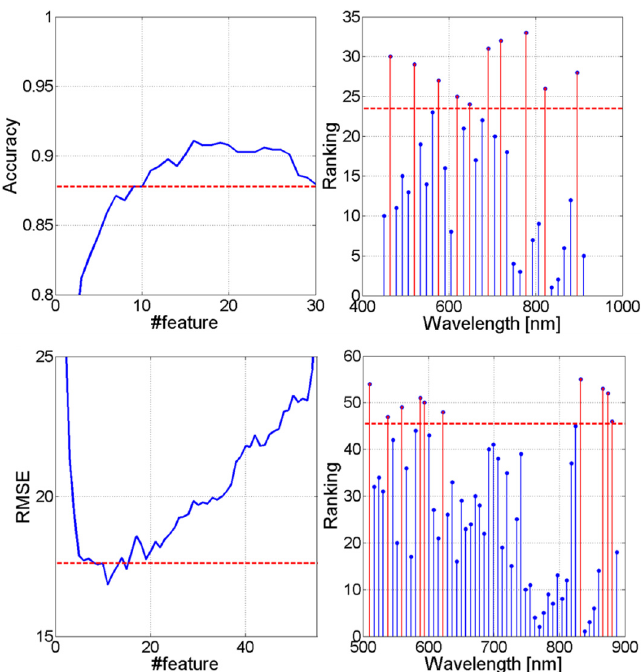
Figure 8. Results of the feature selection for the relevant wavebands for the classification of YR in the field on the ground ( top ) and UAV ( bottom ) scales. The accuracy reached for the different numbers of features ( left ) and the ranking of the inclusion within the feature subset ( right ) is displayed. RMSE = root mean square error.